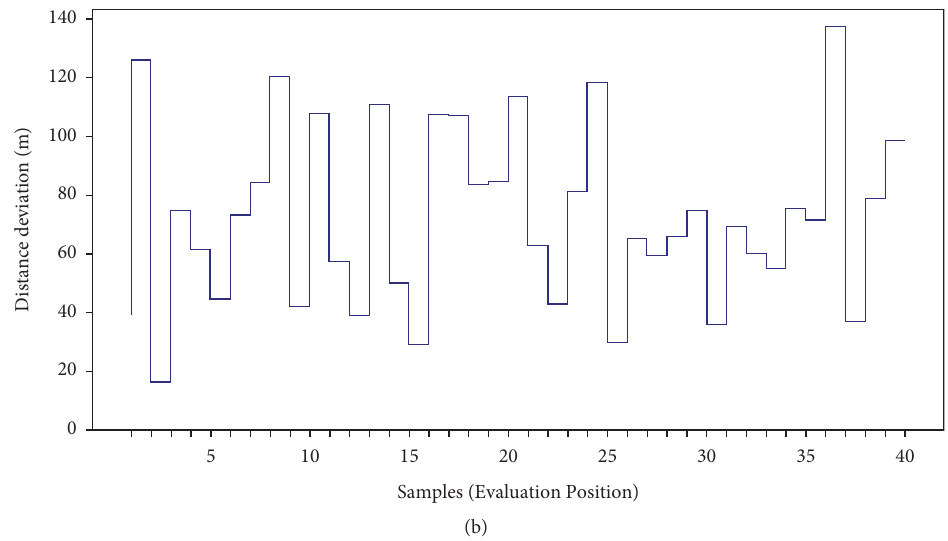
Figure 13: Performance of proposed model for simple sea-ice scene. (a) Recommended and actual courses for simple sea-ice scene. (b) Distance error distribution for simple sea-ice